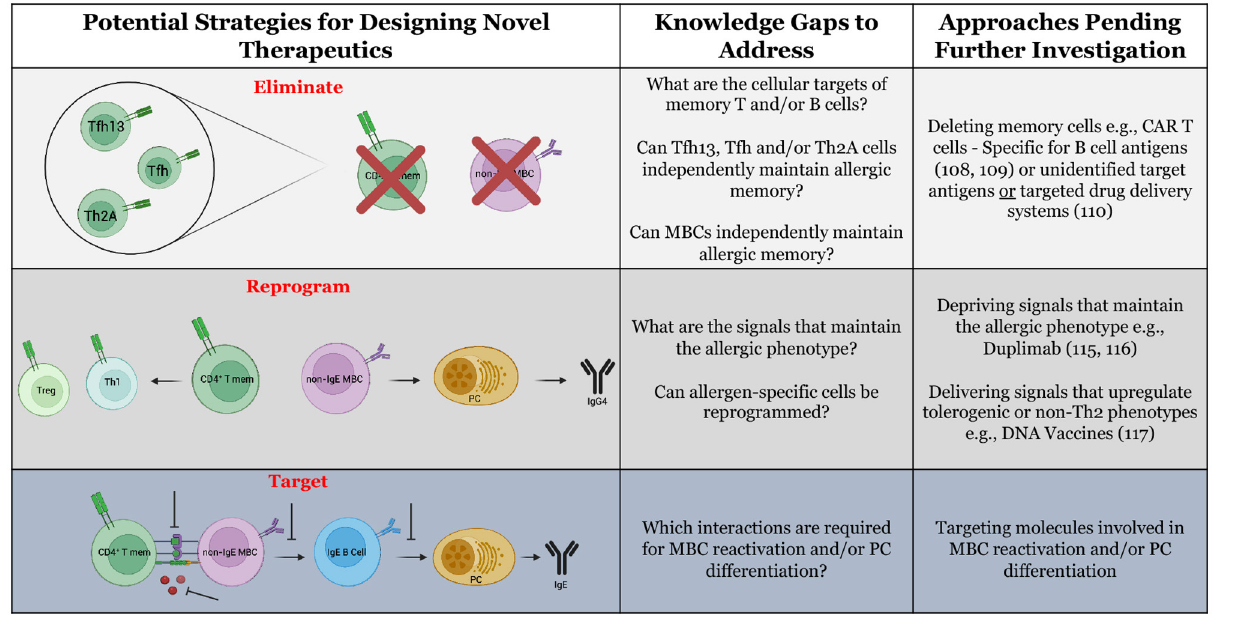
TABLE 3 | Potential strategies for the design of novel therapeutics for food